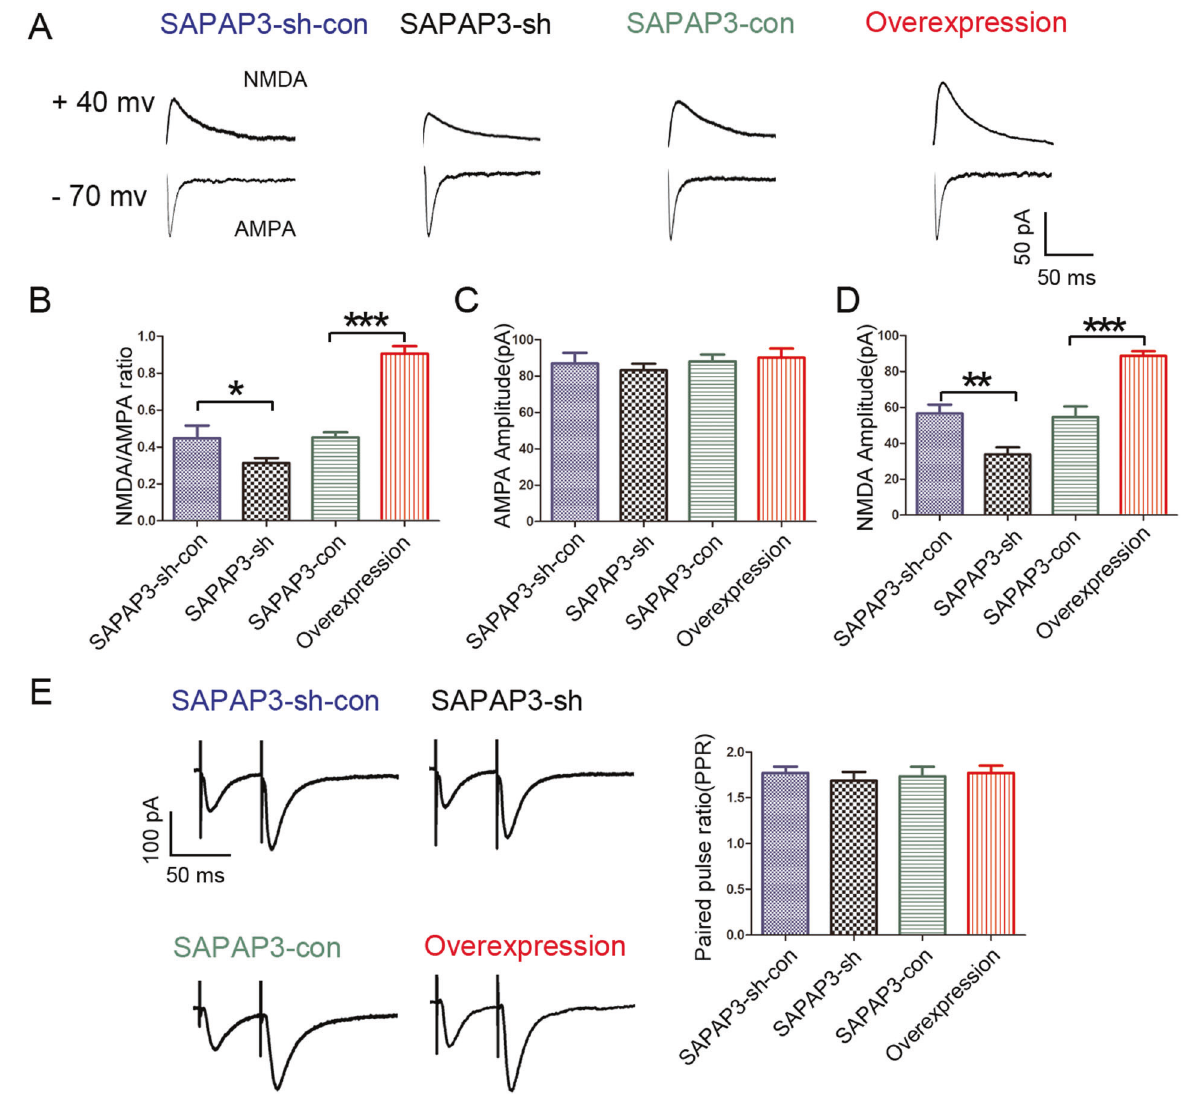
B Summary graph showing that the NMDA/AMPA ratio was lower in the SAPAP3-sh-treated mice than in the controls. SAPAP3 overexpression from the recombinant SAPAP3 LV yielded the opposite results. C The SAPAP3-sh and SAPAP3 overexpression LV affected AMPAR-mediated EPSCs, but the difference was not signi fi cant. D The SAPAP3-sh LV signi fi cantly decreased the average amplitude of NMDAR-mediated EPSCs compared with that of the control group; SAPAP3 overexpression yielded the opposite results. E No signi fi cant difference in the PPRs for AMPAR-mediated EPSCs was found among the groups. Data are presented as means ± SEM, n = 6 per group. * p < 0.05; ** p < 0.01; *** p <